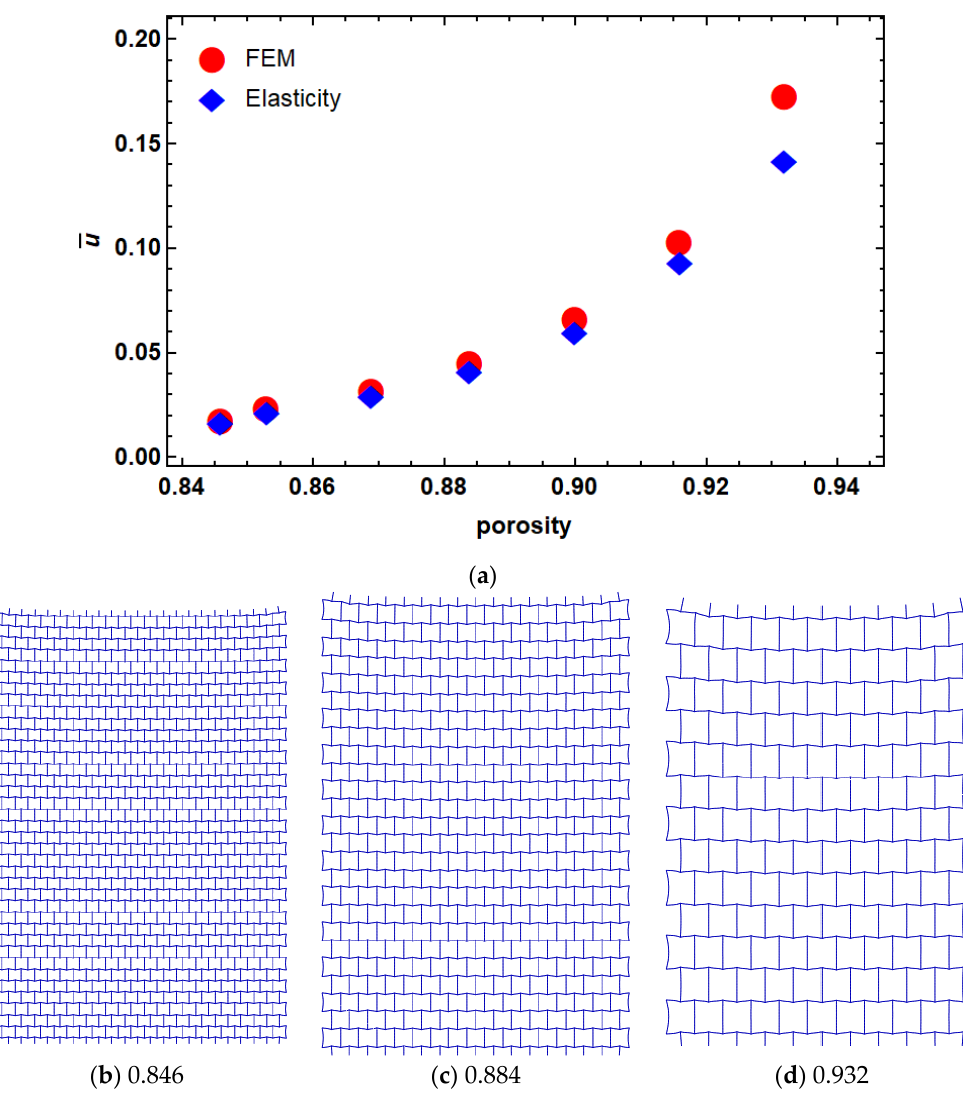
Figure 3. Dimensionless displacement of re-entrant structure with different porosities ( a ) porosity. Examples of different porosity levels are shown subfigures ( b ) 0.846, ( c ) 0.884 and ( d ) 0.932.